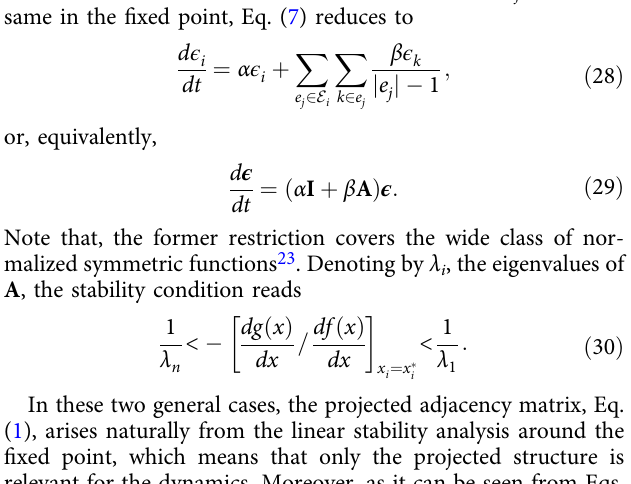
Fig. 2 Different hypergraph projections. Projection of two different hypergraphs built on the same set of nodes, V ¼ f v 1 ; v 2 ; v 3 ; v 4 ; v 5 g . In